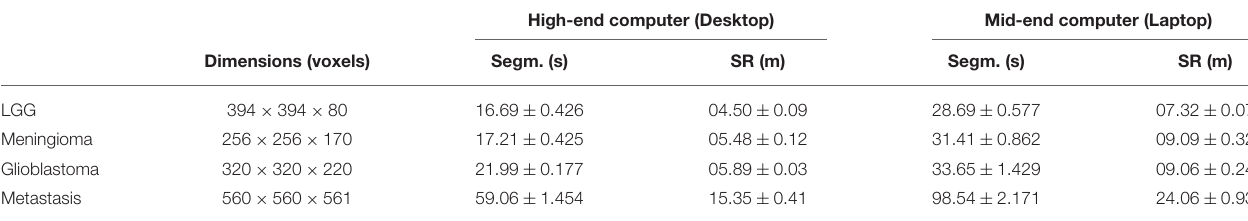
TABLE 10 | Segmentation (Segm.) and standardized reporting (SR) execution speeds for each tumor subtype, using our Raidionics